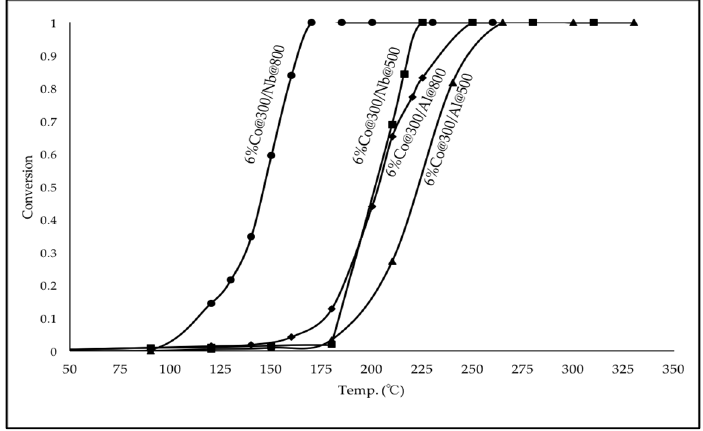
Figure 2. Six percent Co@300/Nb@800, 6% Co@300/Nb@500, 6% Co@300/Al@800 and 6% Figure 2.